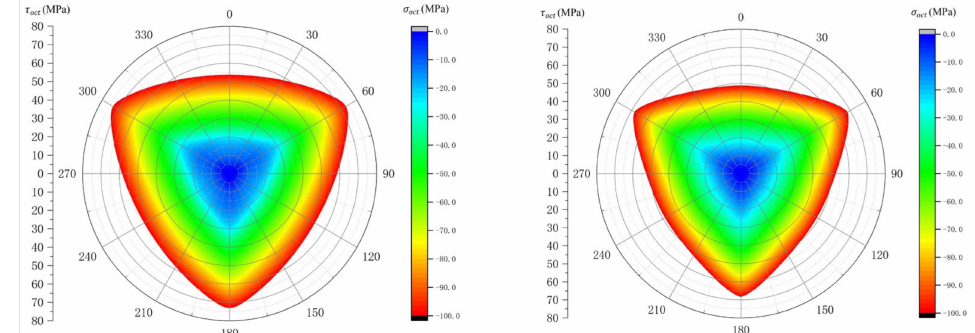
Figure 14. Deviatoric plane of the Ottosen ( left ) and Guo Wang ( right ) criterion.